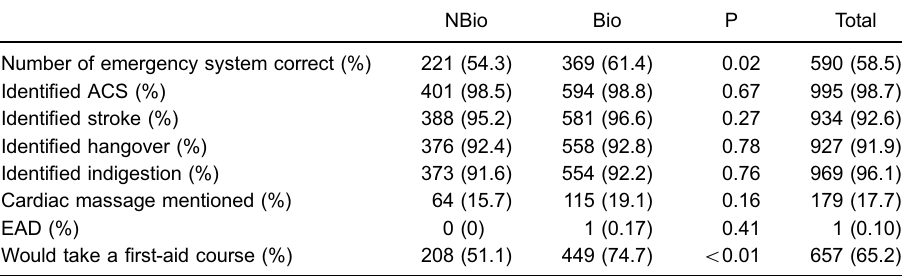
Table 1. Number of correct answers by study subject (non-biological or biological sciences). NBio Bio